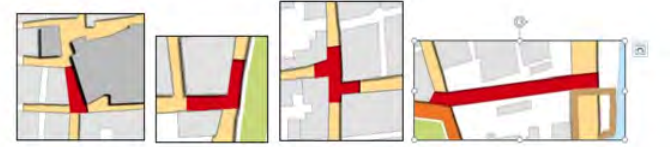
Figure 17. (Arrival/ Departure Spaces of Rashid historic